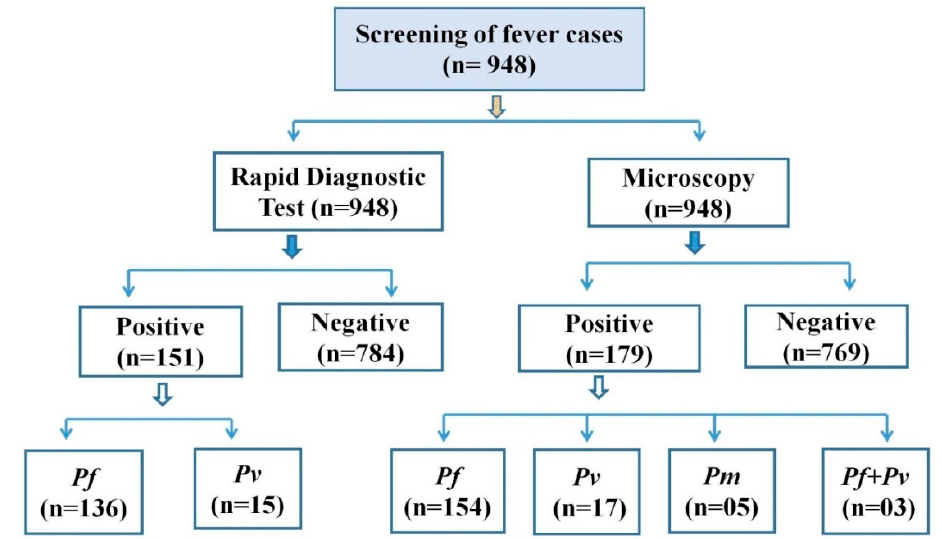
Figure 2. Screening of the fever cases and malaria positivity at the study site ( Pf = P. falciparum ; Pv = P. vivax ; Pm = P. malariae ).